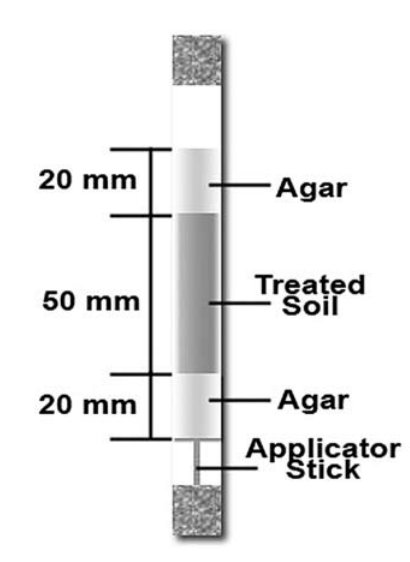
Fig. 1. Schematic showing components of glass-tube arenas used in FST feeding cessation